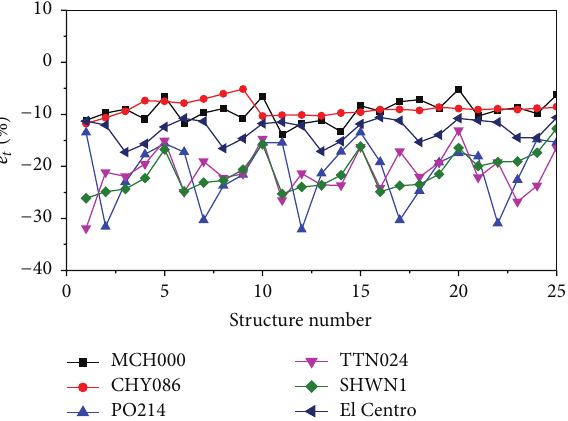
Figure 10: Interaction among structures in terms of influence coefficients 𝑒 𝑡 for different incident waves (URBAN10-10, 𝐷 = 0.5 , 𝑆𝑋 ).